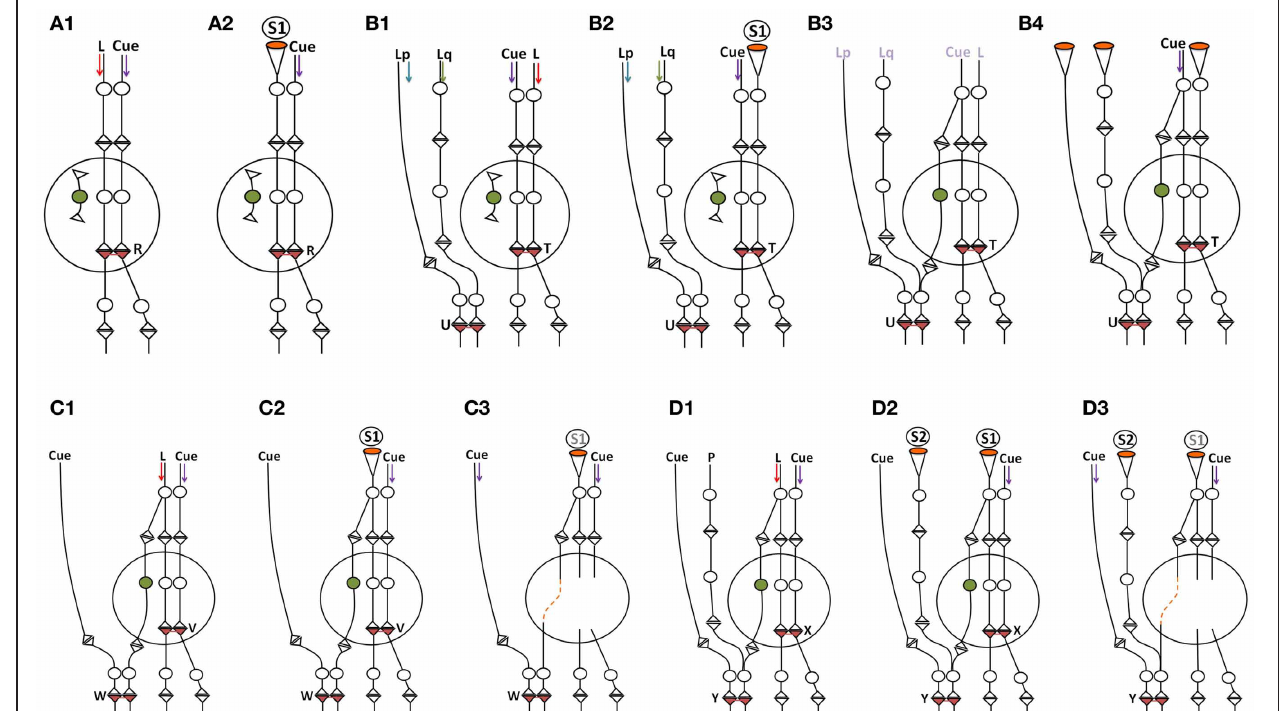
The labels are given in light colors to denote that there are no active stimuli at this time point. (B4) Memory retrieval following the incorporation of a new neuron by the cue stimulus induces unrelated semblances through the inter-postsynaptic functional LINK at location U that reduces